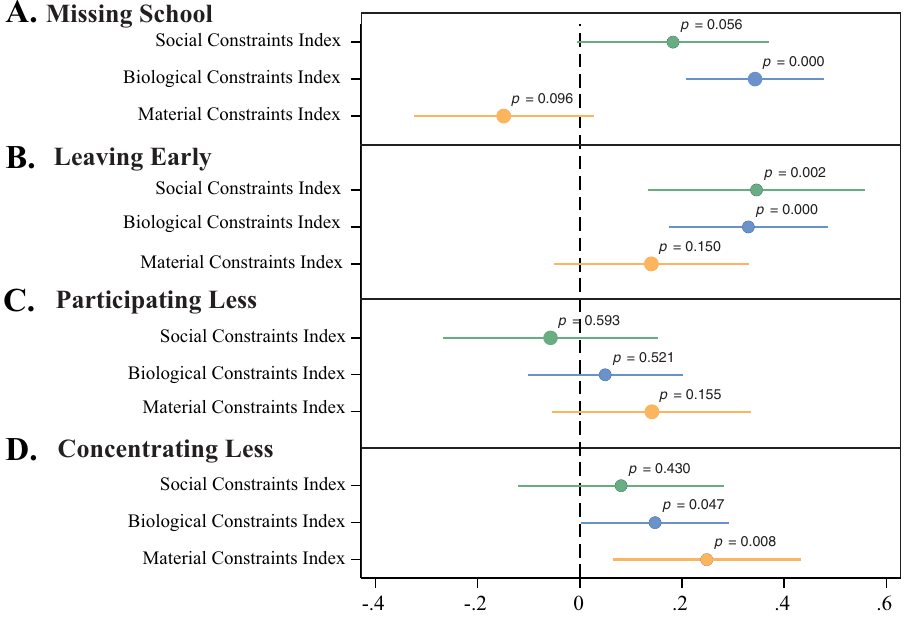
Fig 4. Regression results: Effect of constraints on educational outcomes. The figure above depicts plotted regression coefficients for each constraint type and its relationship with each educational outcome of interest. The model includes three constraint types: social, biological, and material and four educational outcomes: A) “During your last period, were there days when you could not come to school because of your period?” B) “During your last period, did you